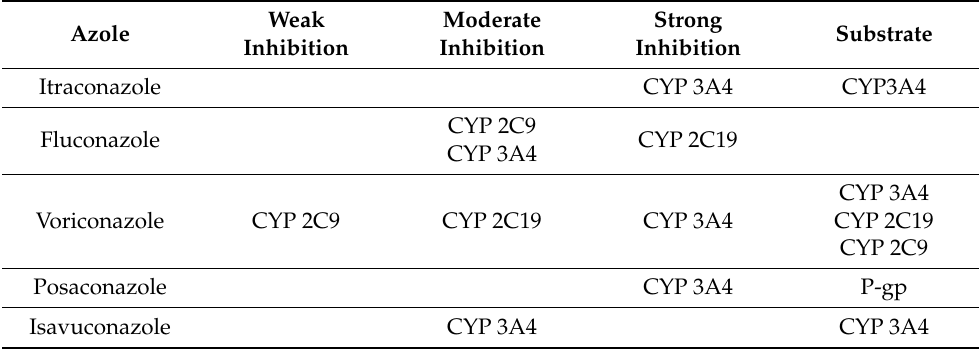
Table 3. Metabolism and CYP inhibition of currently marketed